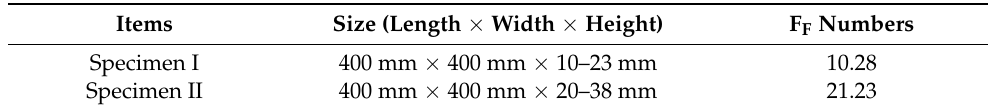
Figure 4. Two test specimens for validation: ( a ) specimen I with the F F number of 10.28 and ( b ) specimen II with the F F number of 21.23. Table 2. Dimensions and F F numbers of the specimens.